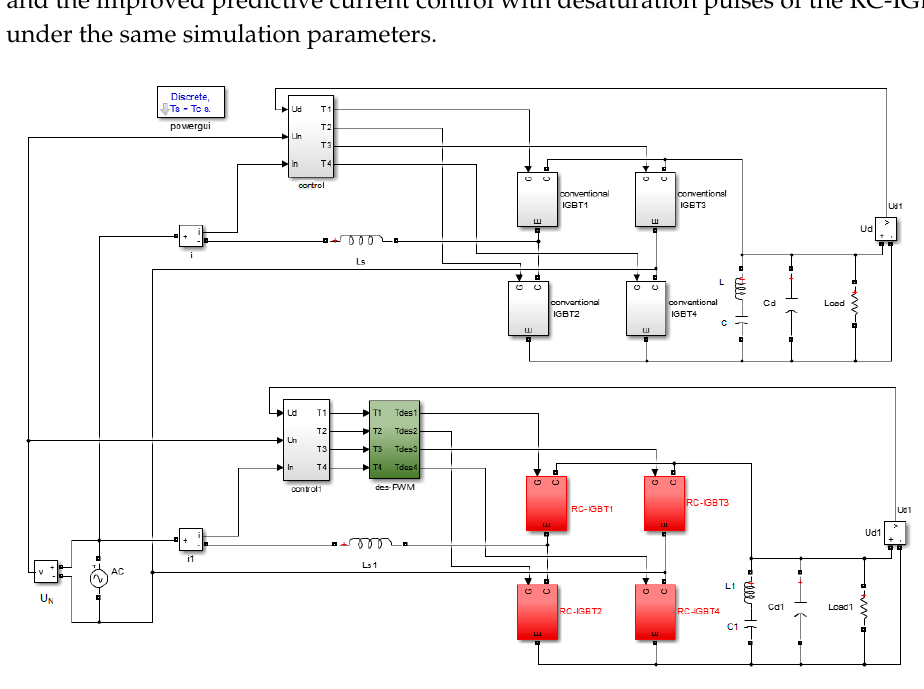
Figure 10. The simulation circuit of the single-phase PWM rectifier under saturation control and desaturation control. desaturation